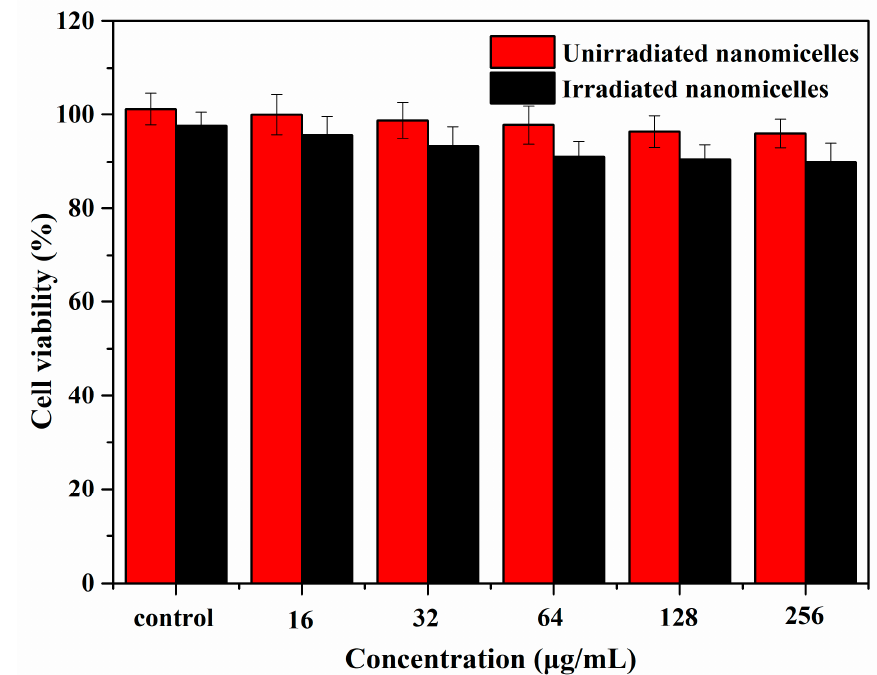
Figure 9. Cytotoxicity of blank mPEG-PEI-(NBS, OA) upconversion nanomicelles with or without irradiation at 980 nm against A549 cells.